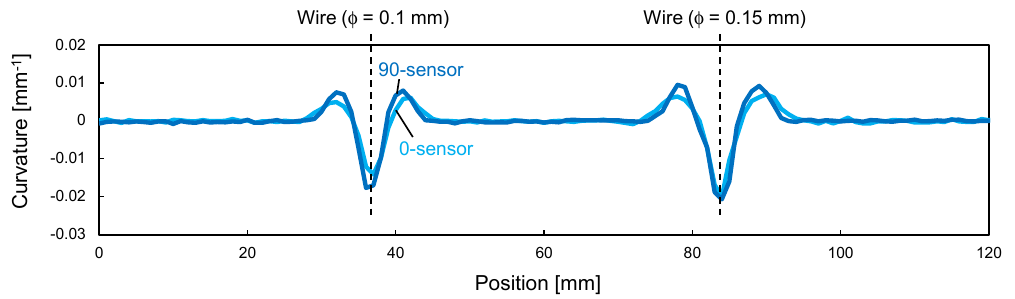
Figure 8. Curvature distribution calculated from strain data.